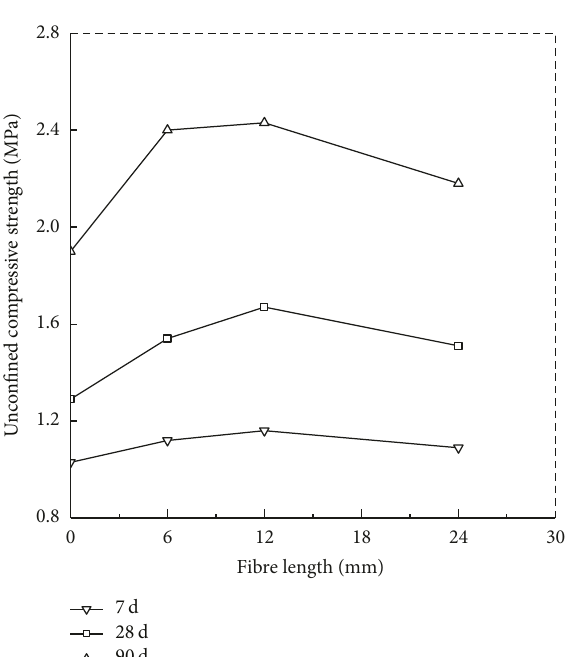
Figure 5: The relations of fibre length and